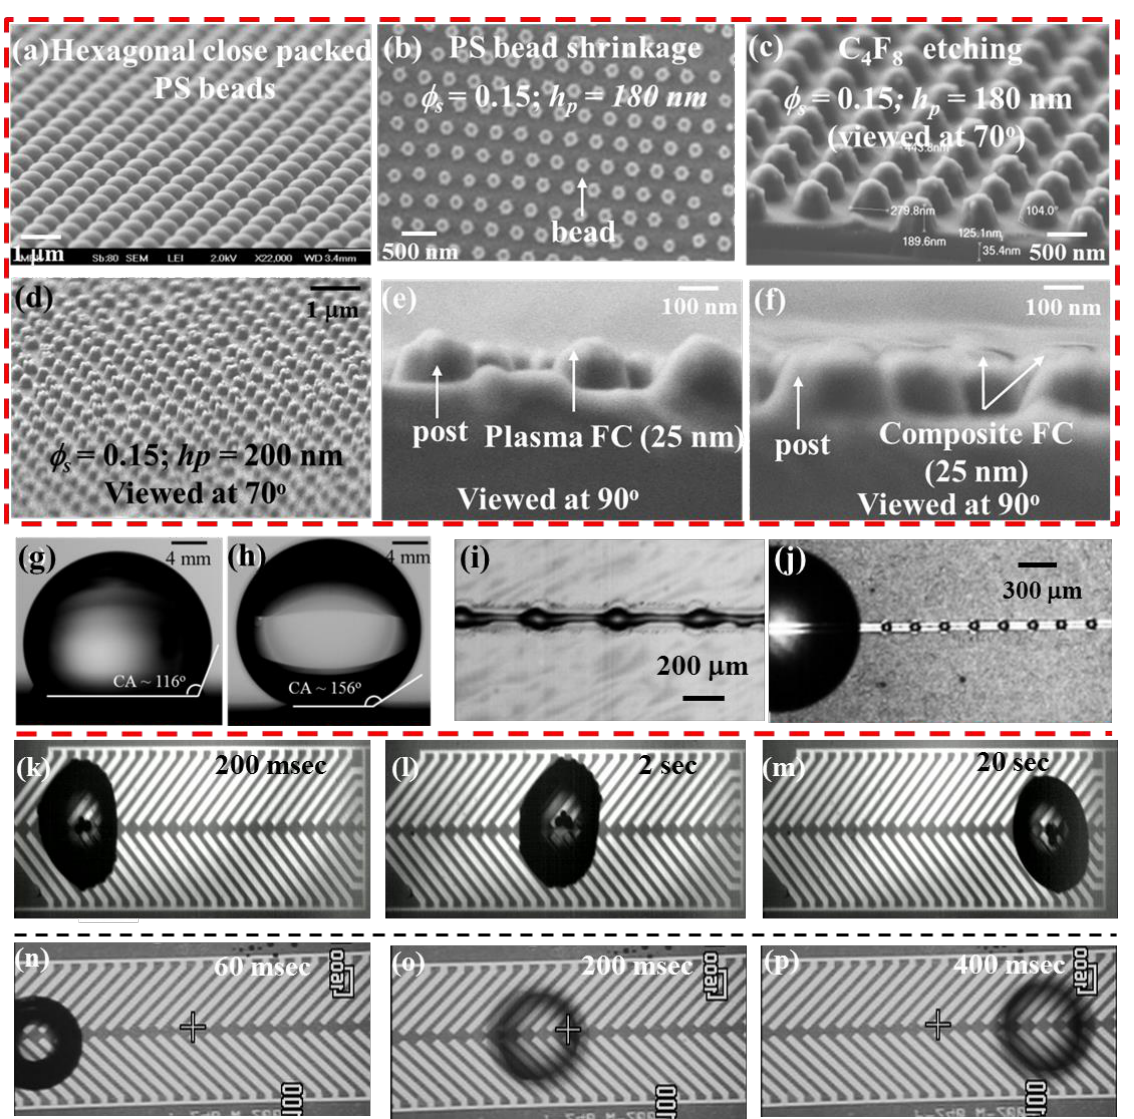
Figure 3. ( a – f ) Steps involved in the nano-texturing of a DMF micro-chip using soft-lithography (reproduced with permission from [49]); ( g , h ) a 5-µL de-ionized water droplet over a hydrophobic and a superhydrophobic (SH) surface; ( i,j ) micrograph showing the performance of L-DEP over a hydrophobic and a SH surface; ( k – m ) a 1-µL PCR droplet during D-DEP actuation over a hydrophobic surface; ( n – p ) a 1-µL PCR droplet during D-DEP over a SH surface. FC,